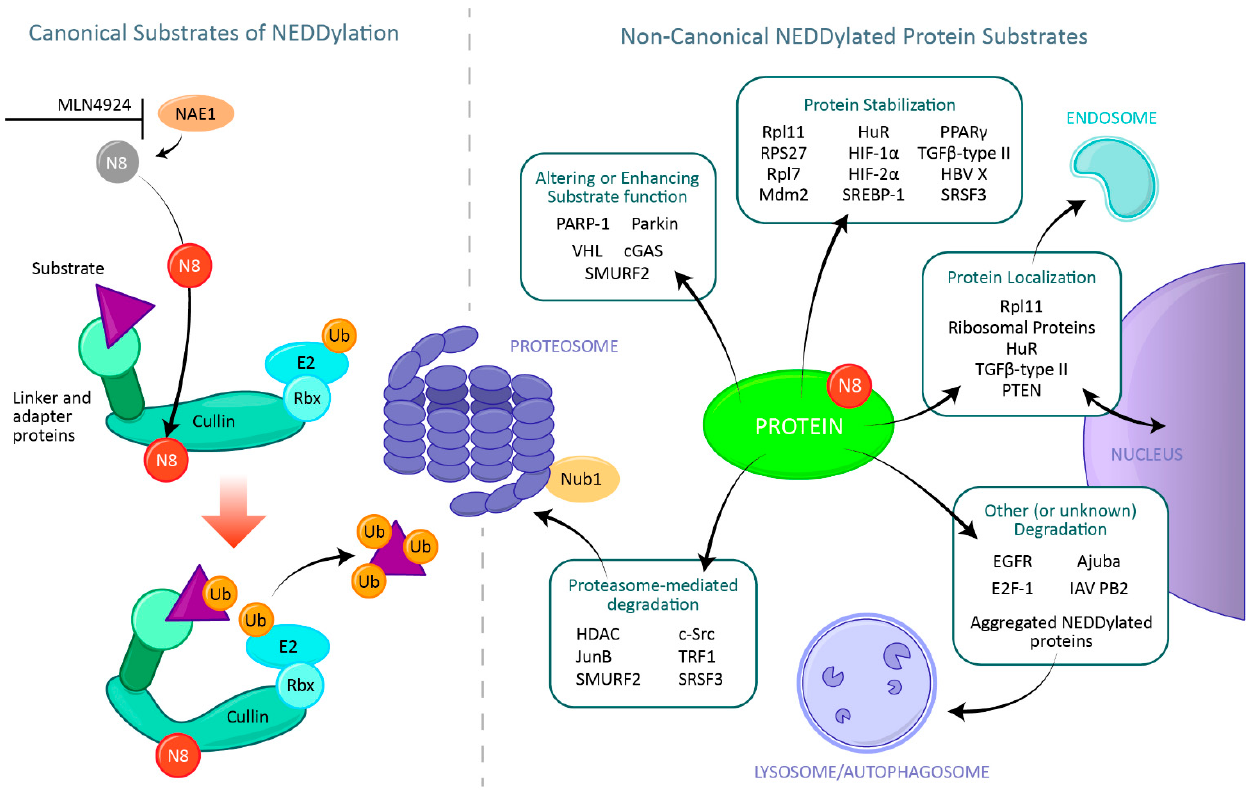
Figure 1. Canonical and non-canonical NEDD8 substrates. Canonical NEDDylation refers to the post-translational modification of the Cullin family of proteins with NEDD8. NEDD8 is first activated by binding to the E1 NEDD8 activating enzyme, a process which can be blocked by the small molecule MLN4924. NEDD8 is then transferred via E2 and E3 enzymes to the Cullin protein, which in turn activates the CRL allowing it to transfer ubiquitin molecules to its designated substrate, leading to the substrate degradation. Non-canonical NEDDylation occurs when NEDD8 is covalently attached to protein substrates other than Cullin molecules. Following NEDDylation these proteins can adopt different fates, such as increased stability, increased enzymatic activity, changes in subcellular location, and degradation. Examples of substrates subject to these outcomes are listed. The list presented here is by no means exhaustive.